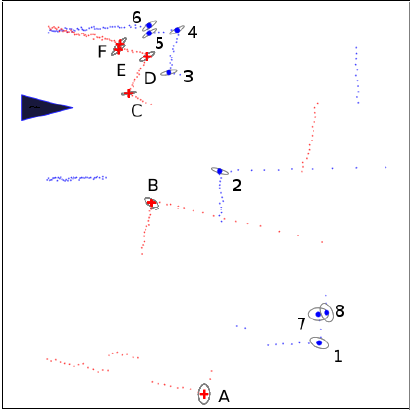
Figure 12. Detected Features at Two Different Time Points. Red plus mark and blue red points indicate two sets of features that were detected at different time points through the proposed method. The observation positions are indicated by the black triangle. Grey ellipses indicate 3 δ uncertainties and numbers and letters are index of features. The ground truth data is that A=1, B=2, C=3, etc . Feature 7 and 8 has no corresponding feature, due to having a different view of the environment.